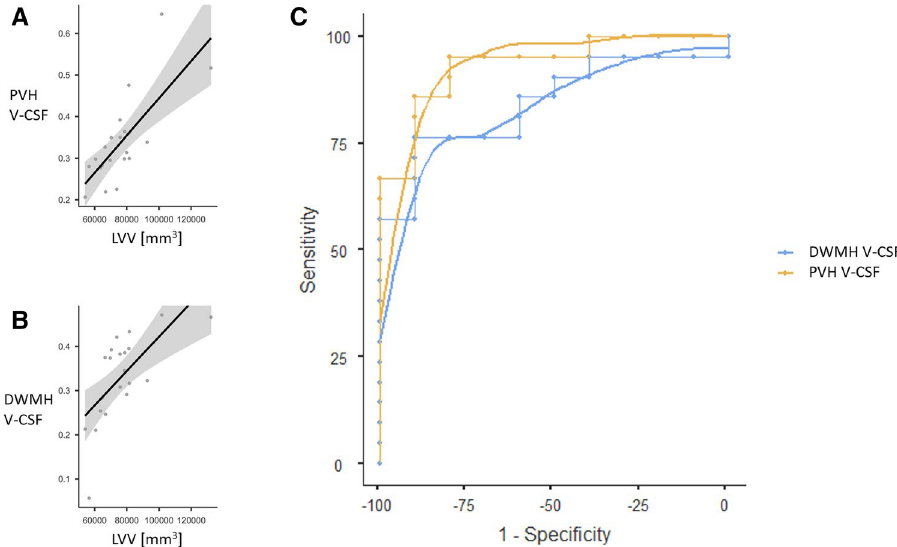
Figure 6. Scatterplots describing the associations between periventricular cap (PVH) V-CSF and lateral ventricular volume (LVV [mm 3 ]; ( A ); deep white matter hyperintensity (DWMH) and LVV ( B ) in 21 patients with presumed iNPH. Receiver operating characteristic (ROC; C ) of 21 patients with presumed iNPH and 10 controls showing high predictive value of both PVH V-CSF (AUC 0.933) and DWMH V-CSF (AUC 0.843) regarding iNPH defined by Radscale image criteria (Kockum et al. 40